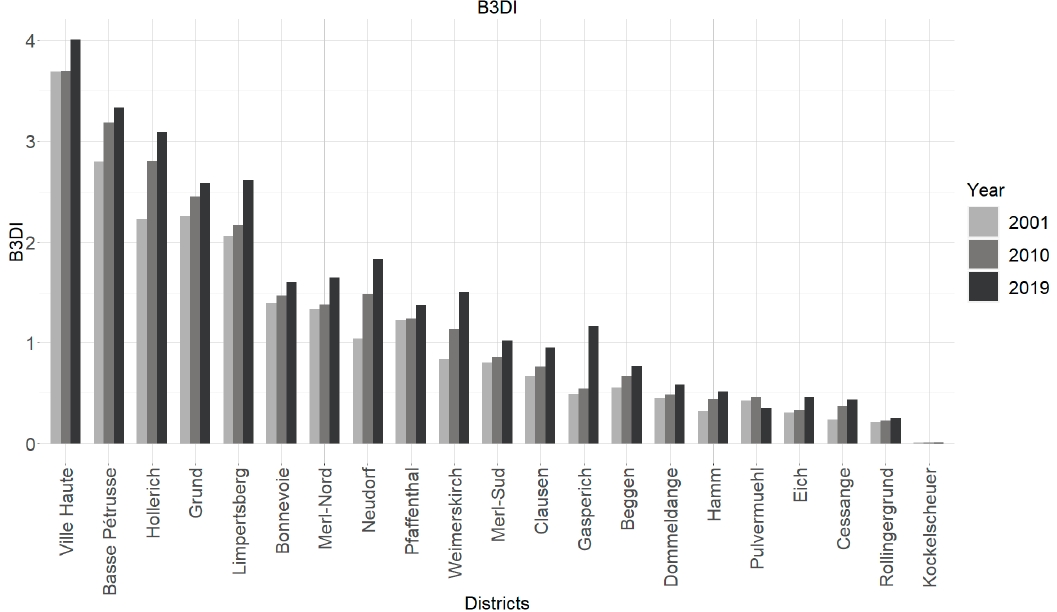
Figure 16. The B3DI value of Luxembourg City districts of in years 2001, 2010, and 2019.